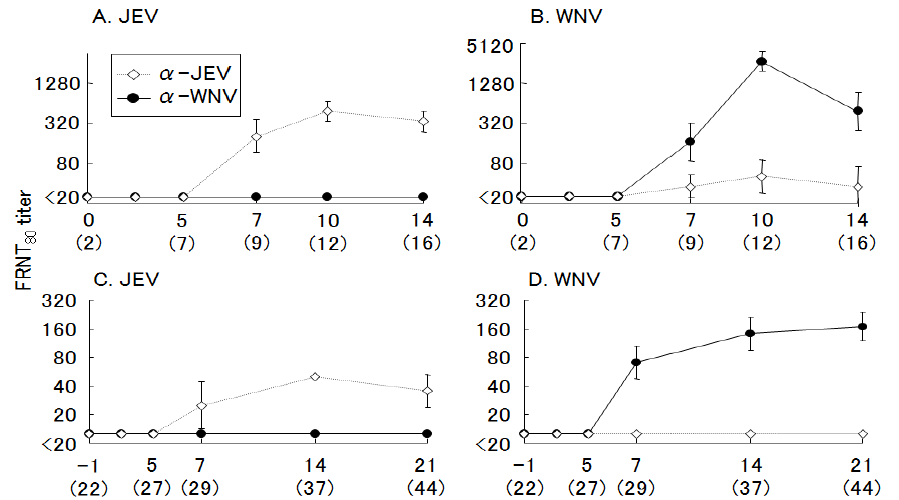
Days post inoculation (age of clicks in